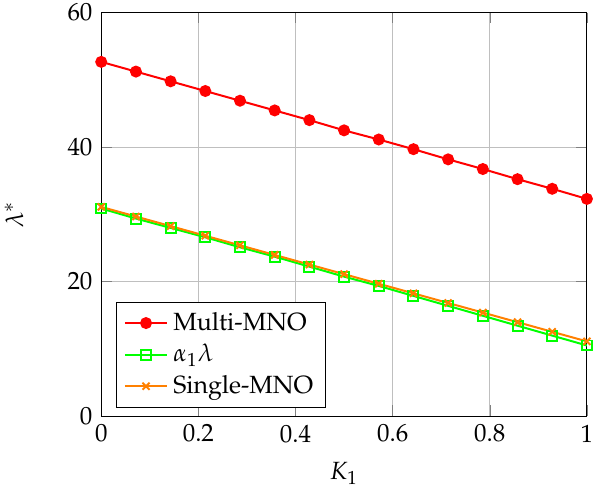
Figure 10. MNOs and MVNO network capacity as a function of K 1 with K 2 =